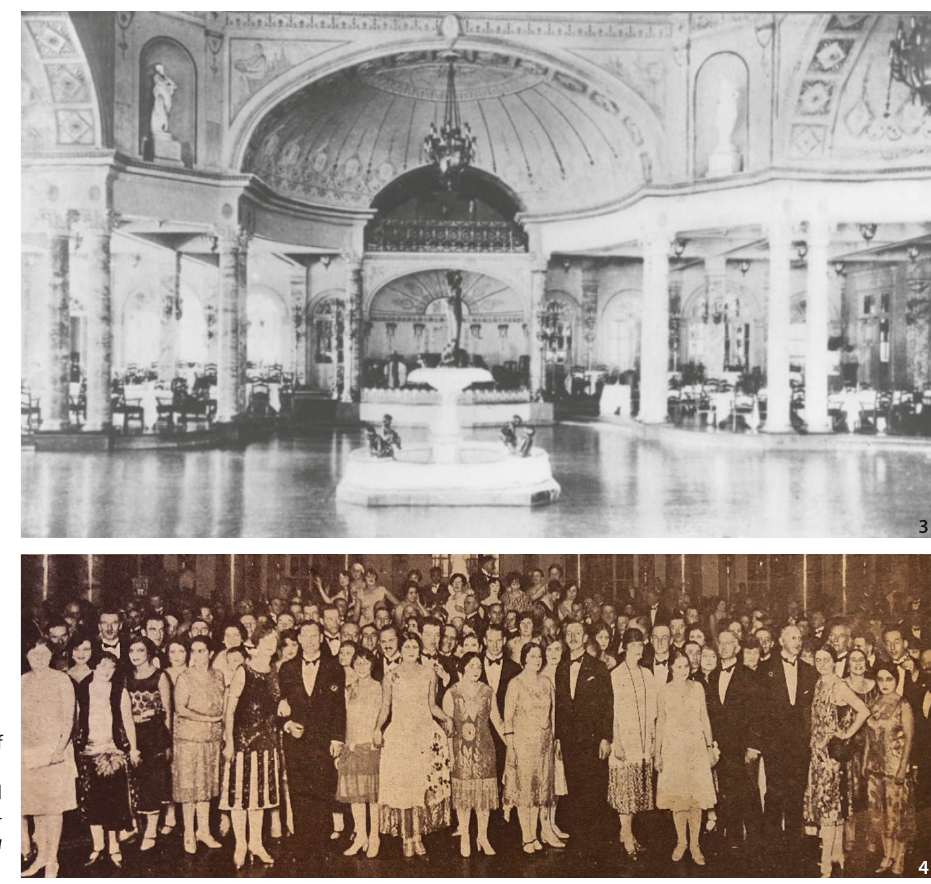
Figure 3 Majestic Ballroom (Source: a collection of photos of Shanghai from the 1930s). Figure 4 Russian Charity Ball and fashion show given at the Majes- tic Hotel Ballroom (Source: China Press , December 25,